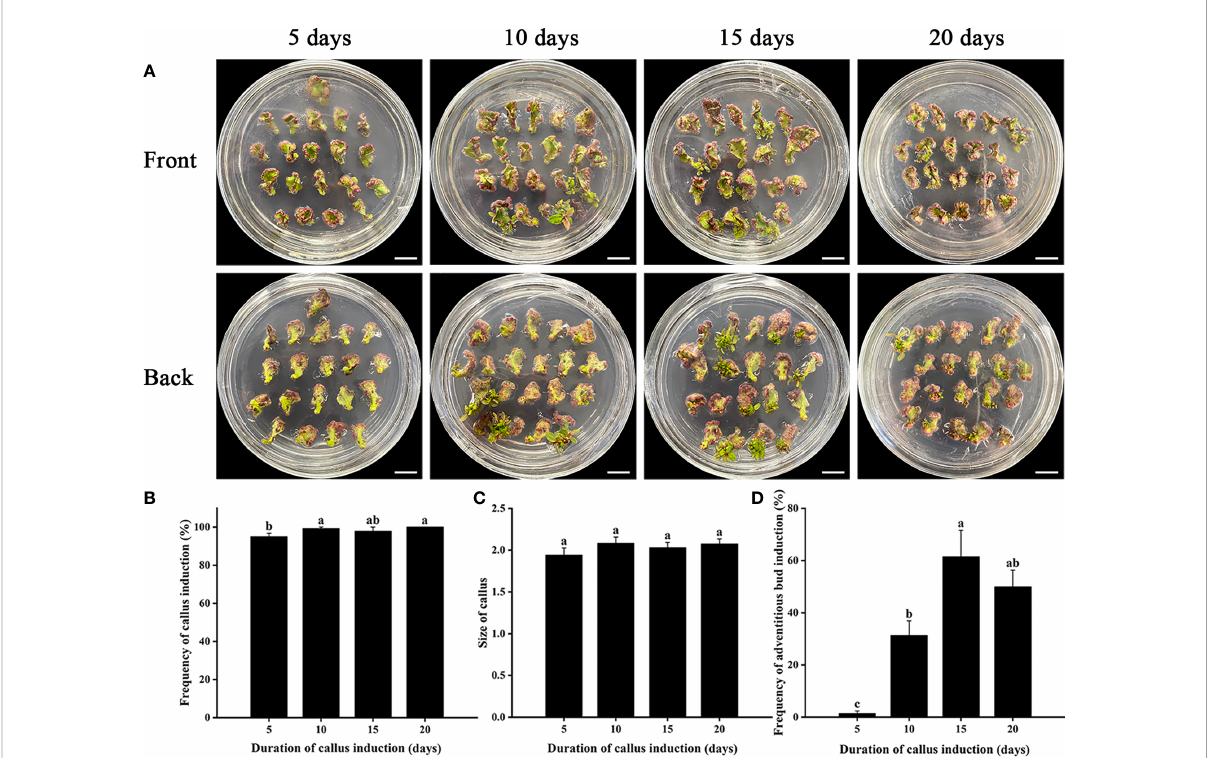
FIGURE 1 Effects of different durations of callus induction on adventitious bud induction of E. urophylla × E. grandis DH32-29. (A) Explants are induced to form calli for 5, 10, 15, and 20 days. Effects of different durations of callus induction on (B) the frequency of callus induction, (C) callus size, and (D) the frequency of adventitious bud induction. Scale bar: 1 cm. Different letters indicate signi fi cant differences among treatments using Duncan ’ s multiple range test at p <